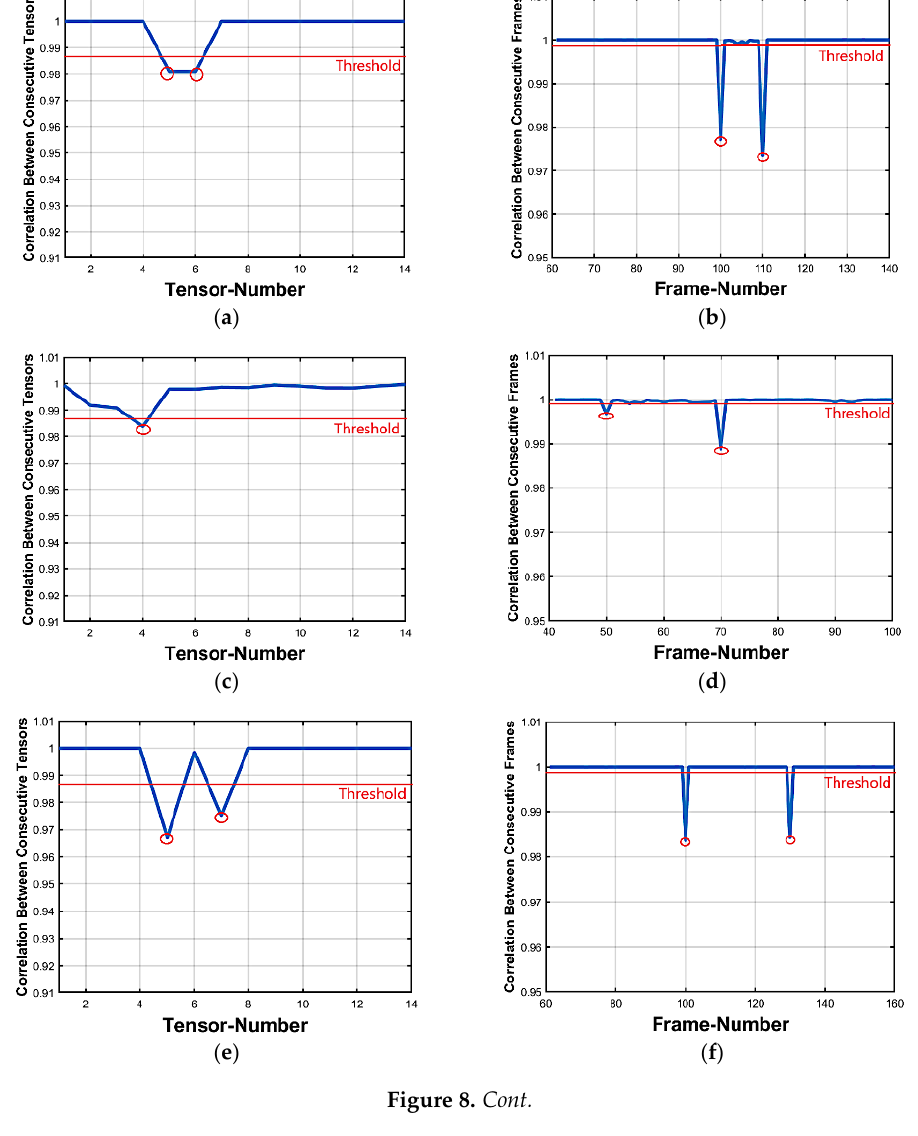
Table 6. Deletion forgery detecting and locating. Results based on SVD-tensor features.